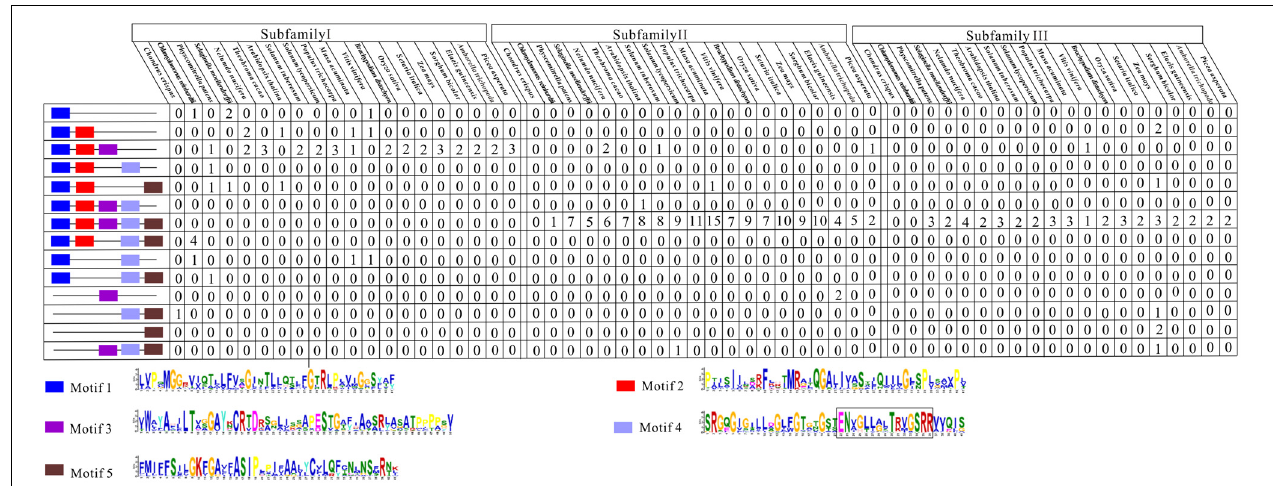
FIGURE 4 | Conserved motifs of NCS2 family proteins in 20 species. Conserved protein motifs in NCS2 proteins were identified using the MEME program. Motifs are indicated with different colors. Motif 4 includes the core region of the NCS2/NAT domain